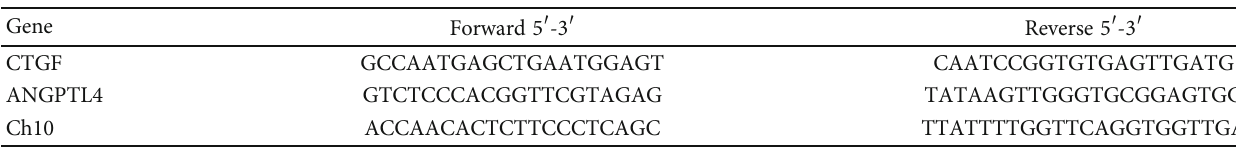
Table 2: Primer sequences.